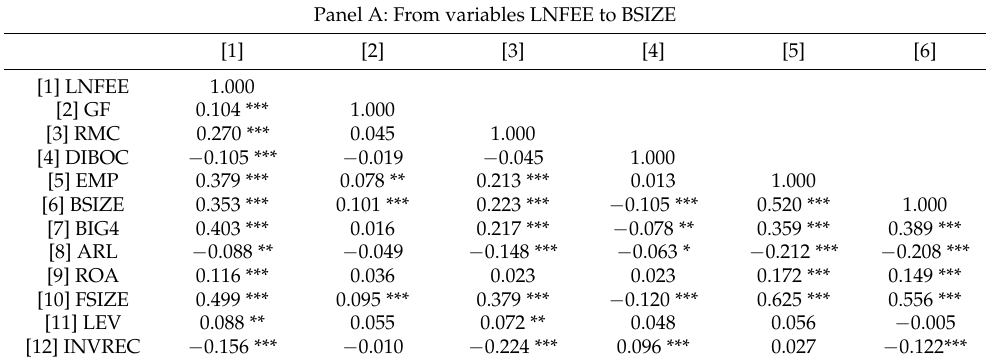
Table 6. Pearson